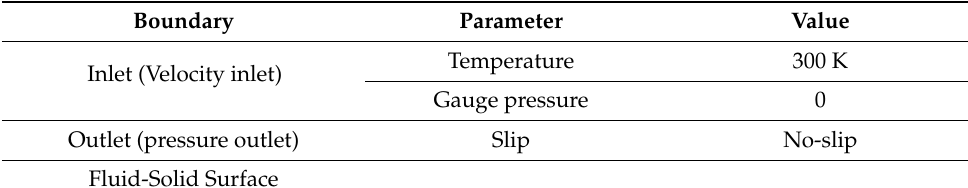
Table 2. Model-related parameter settings.